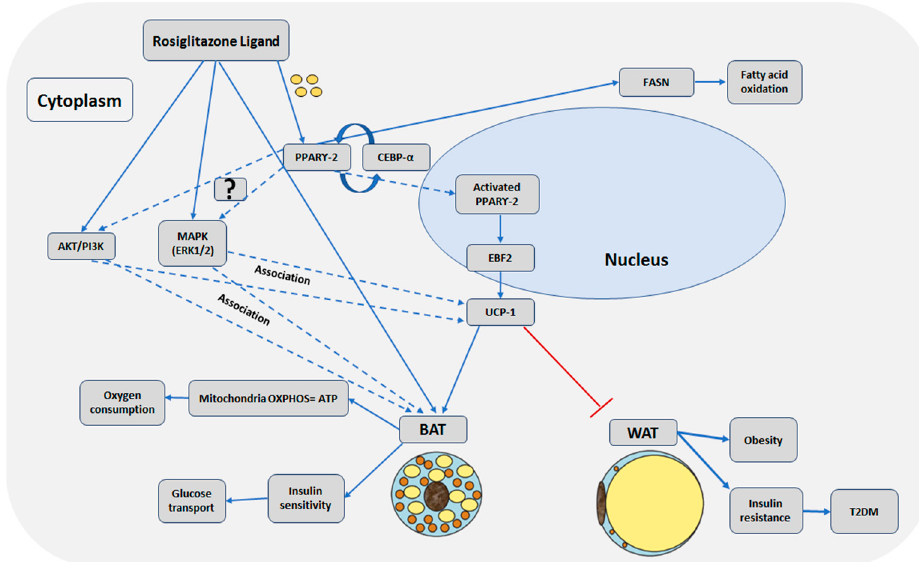
Figure 6. Schematic illustration of possible molecular mechanisms for Rosiglitazone enhanced browning of adipocytes. Solid line arrows indicate activation or induction, dotted line arrows indicate association that needs further confirmation of activation, and the red “T” arrow indicates inhibition.